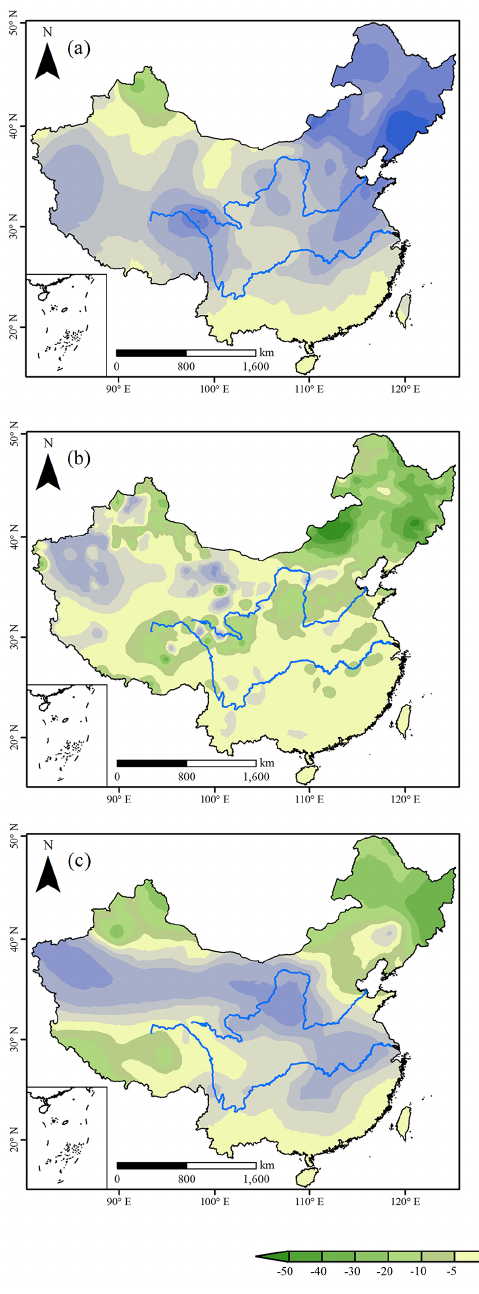
Figure 5. SCDs anomalies in 1957 (a) , 2002 (b) and 2008 (c) , anomaly of snow cover onset date (SCOD) in 2006 (d) , and anomalies of snow cover end date (SCED) in 1957 (e) and 1997 (f)